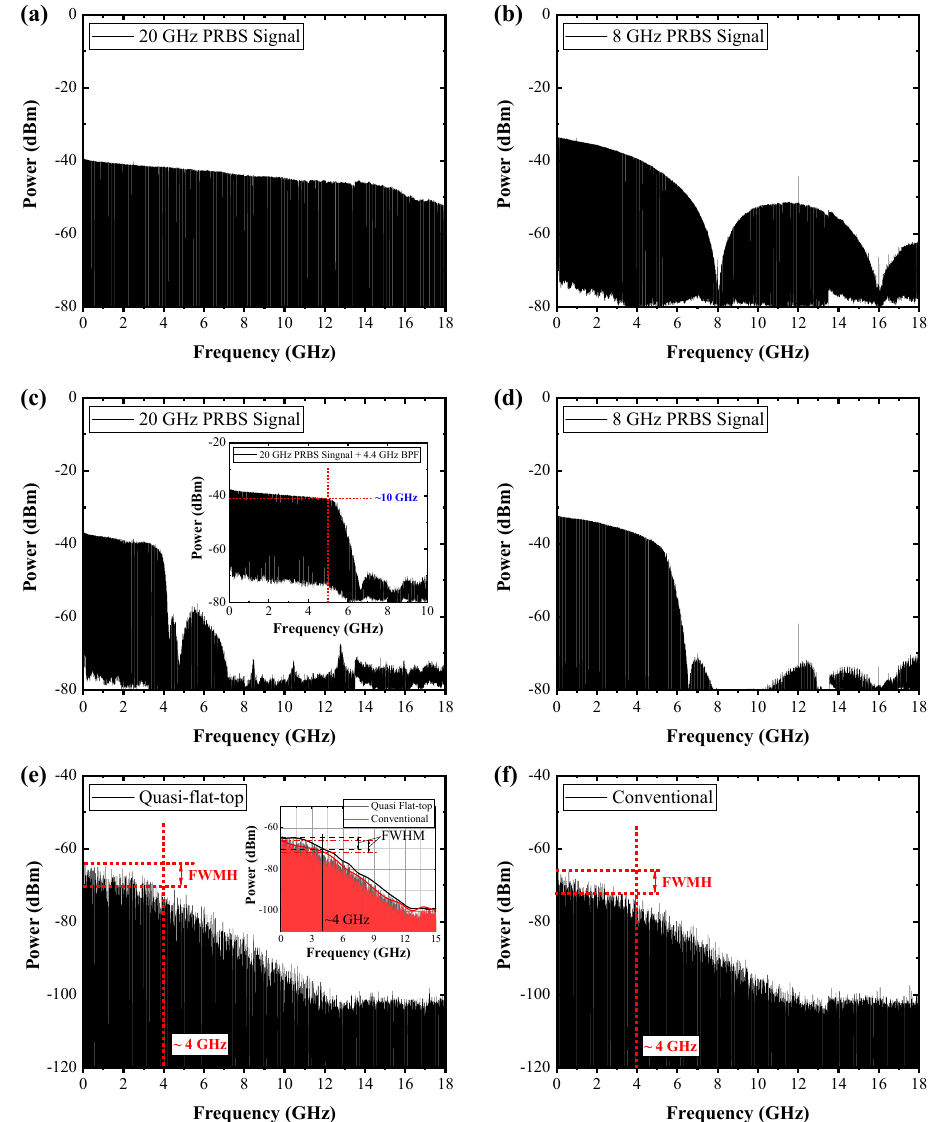
Figure 2. Measured RF spectra of the generated PRBS signal from PRBS generator: ( a ) at 20 GHz; ( b ) at 8 GHz. Measured RF spectra of filtered PRBS signal: ( c ) 3.4 GHz BPF (inset: measured RF spectrum with 4.4 GHz BPF); ( d ) 4.4 GHz BPF. Measured linewidth of the seed source with phase modulation: ( e ) 8 GHz quasi-flat-top PRBS (inset: multiplot graph with ( e , f )); ( f ) 8 GHz-conventional PRBS modulation.